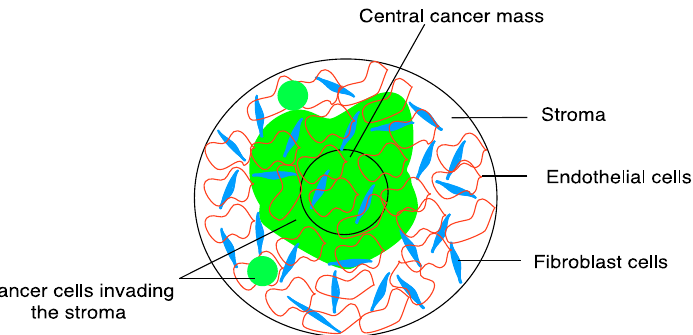
Figure 1. Schematic of ovarian tumouroid. The central cancer mass is manufactured by mixing HEY ovarian cancer cells and collagen type 1, allowing it to set as hydrogel and applying absorbers (RAFT TM ) to remove liquid and create a stiff, compressed 3D tissue. The cancer mass is placed in a large “stromal” hydrogel populated by fibroblasts (HDFs) and endothelial cells (HUVECs), with further addition of stromal hydrogel-cell mix. The whole construct is compressed (RAFT TM ) to produce complex tumouroids. Tumouroids are allowed to mature for 7 days, with cancer invading from the cancer mass into the stroma, prior to exposure to the drug.